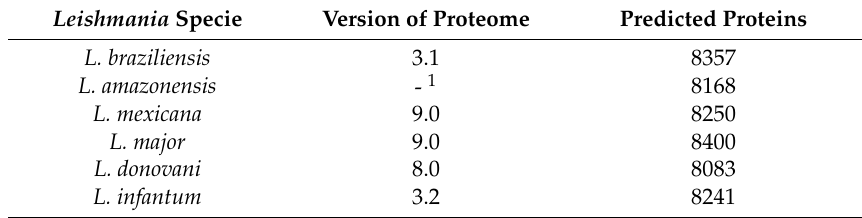
Table 3. Leishmania predicted proteomes used in the study. The version and number of predicted proteins of each species are